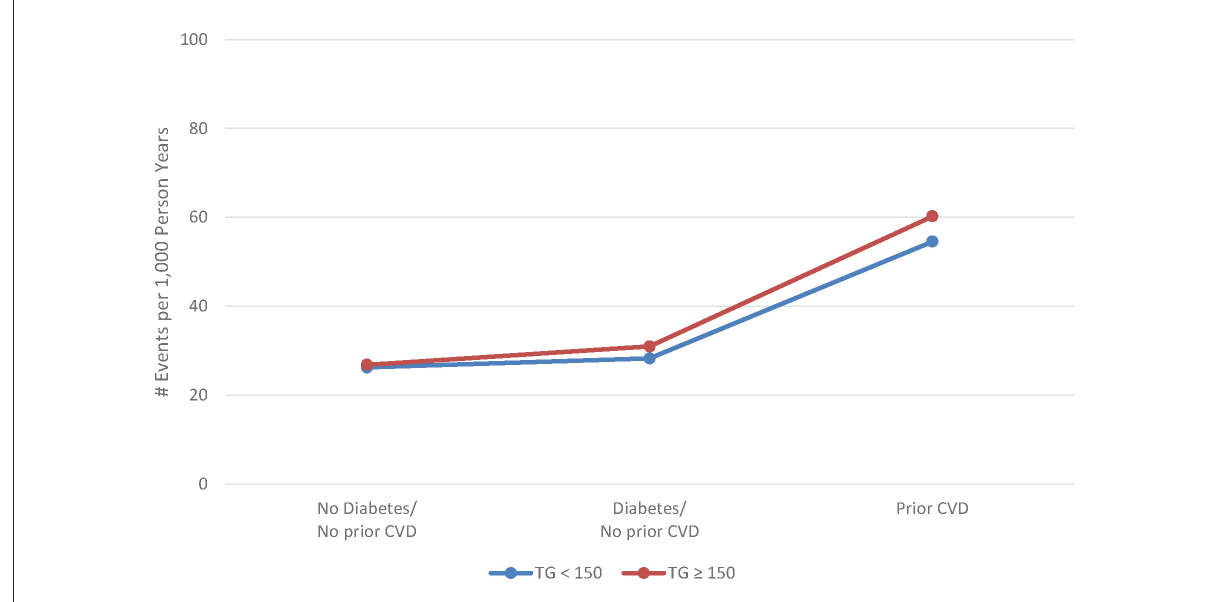
FIGURE2 Adjusted rate of major cardiovascular events by cardiovascular risk and triglyceride